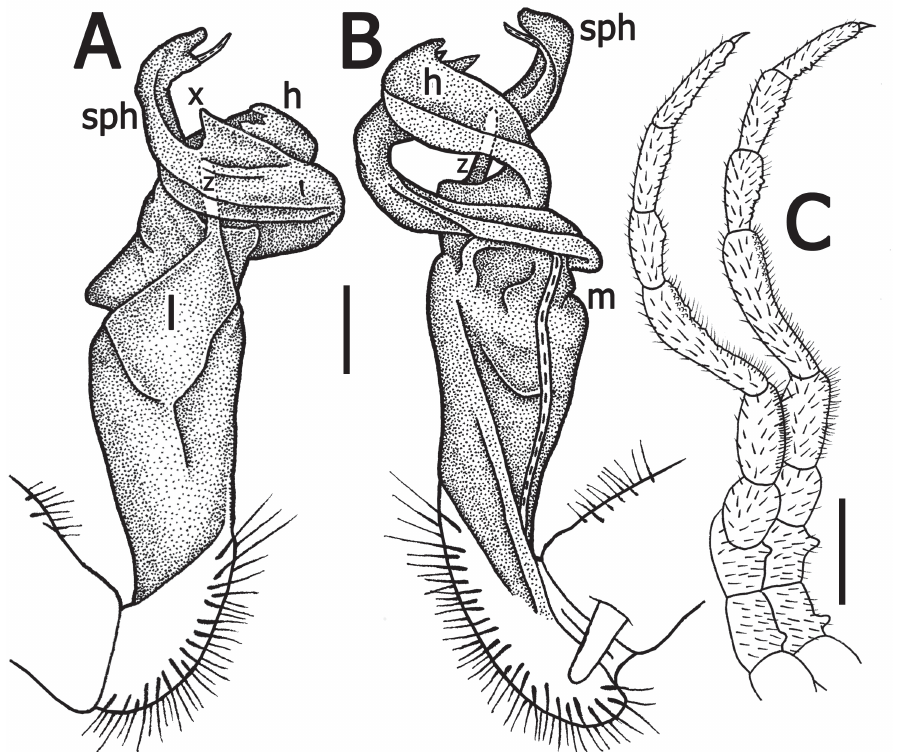
Fig. 19. Tylopus thunghaihin sp. nov., holotype, ♂. A–B . right gonopod, lateral and mesal views, respectively. C . Leg of segment 9. Scale bars: A–B = 0.2 mm; C = 1 mm. Abbreviations are explained in the